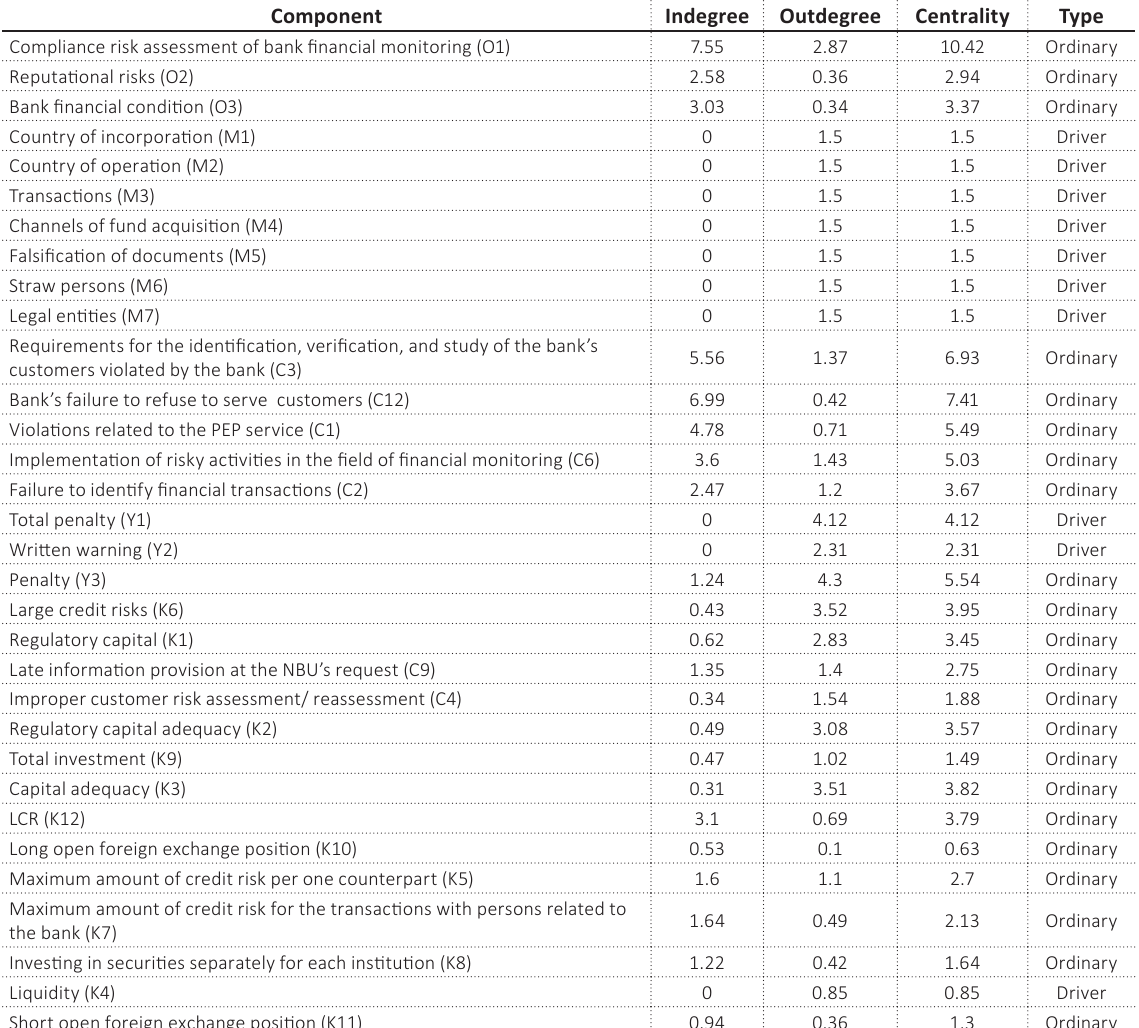
Table 2. Formalization of compliance criteria for banks acting as pension custodians, financial monitoring measures, the extent of banks’ internal compliance and NBU